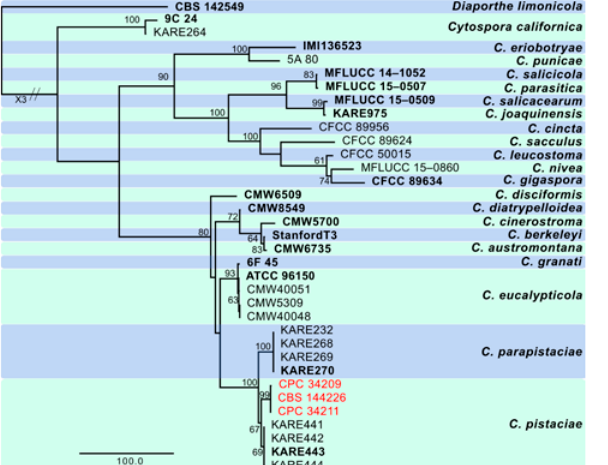
Figure 2. The first of two equally most parsimonious trees obtained from a heuristic search of the combined ITS, act , tef1 and rpb2 sequence alignments of Cytospora spp. Bootstrap support values are shown at the nodes. The strains isolated in this study are shown in red and the scale bar represents the number of changes. The tree was rooted to Diaporthe limonicola (CBS 142549).